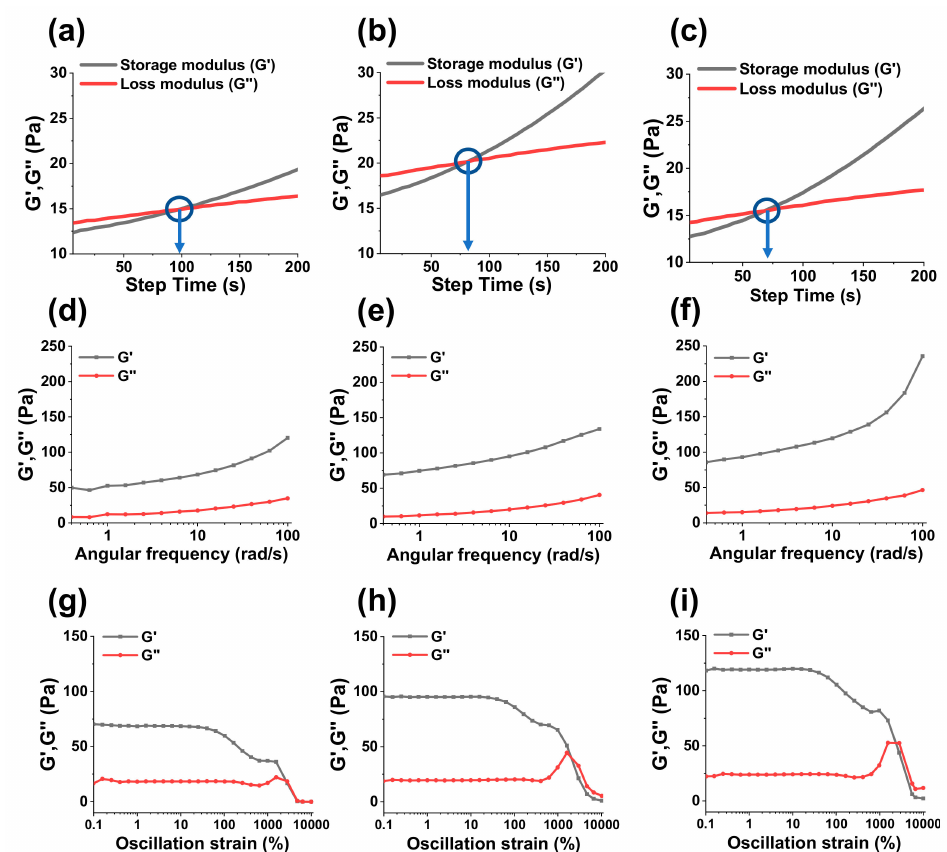
Figure 4. Rheological properties of PTHG-A, PTHG-B, and PTHG-C hydrogels. ( a – c ) storage modulus (G’) and loss modulus (G”) as a function of gelation time, ( d – f ) angular frequency sweep tests, and ( g – i ) amplitude sweep